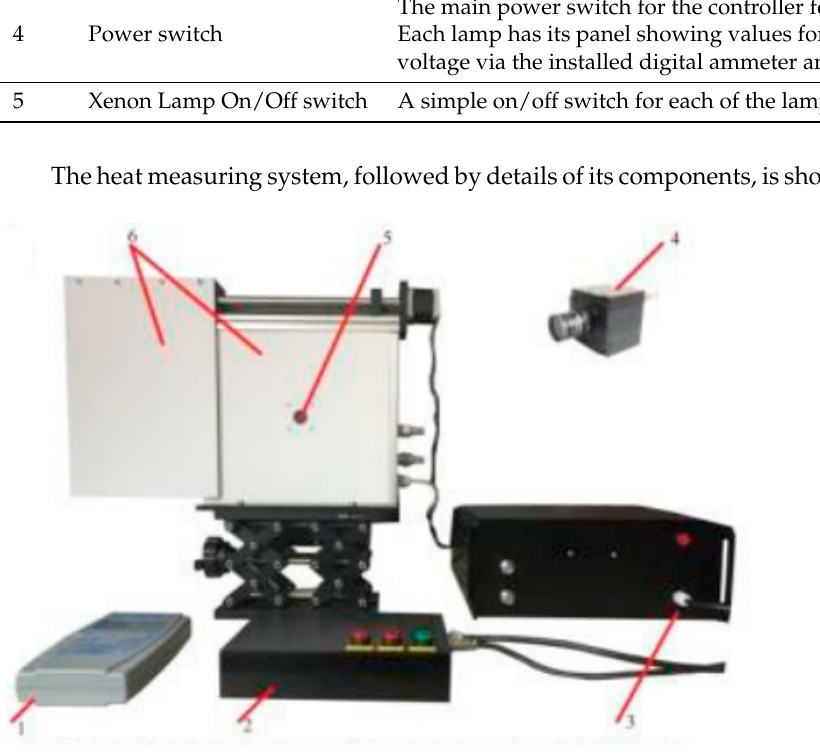
Figure 4. Heat flux measurement system.